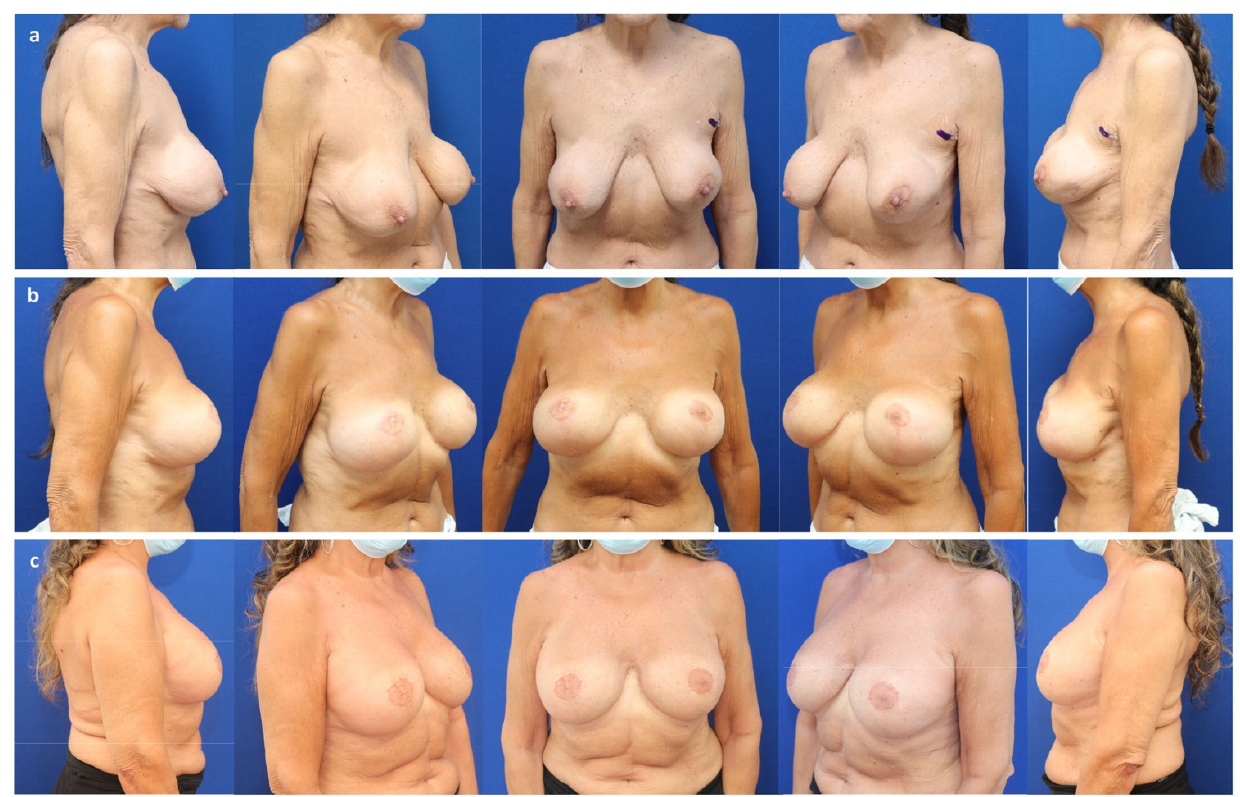
Figure 5. ( a ) A 62-year-old patient with persistent in situ ductal carcinoma (pTis pN0 M0) of the left breast after tumorectomy, as well as bilateral ptosis grade II (Regnault classification) and capsular contracture grade IV (Baker) 30 years after prepectoral augmentation mastoplasty. ( b ) Six months after a bilateral skin reducing mastectomy, free nipple graft, and prepectoral expander placement (Mentor CPX4 550 cc, Mentor Worldwide LLC, Irvine, CA, USA). ( c ) Two years after a bilateral expander exchange for a definitive implant (Motiva Ergonomix ® ERSD 575 cc), synthetic pocket-like mesh (TiLOOP ® Bra Pocket, pfm medical AG, Cologne, Germany), and autologous fat grafting to the mastectomy flaps (210 cc/breast).